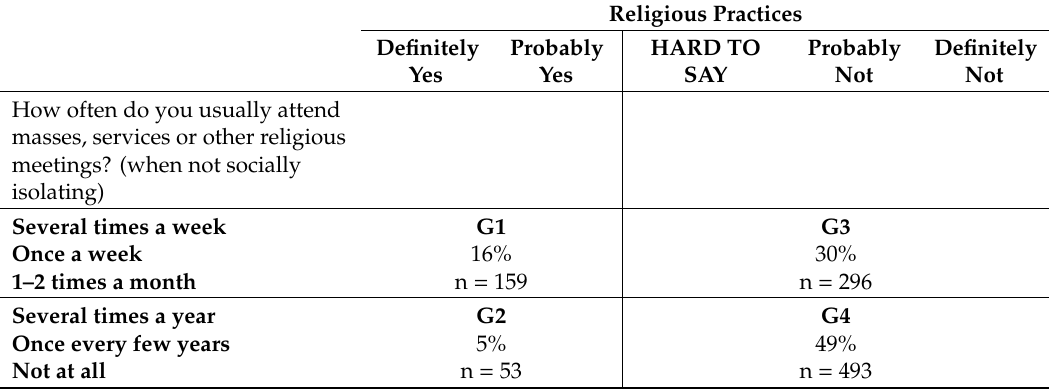
Table A2. Division of respondents into four groups on the basis of answers to the two religiosity